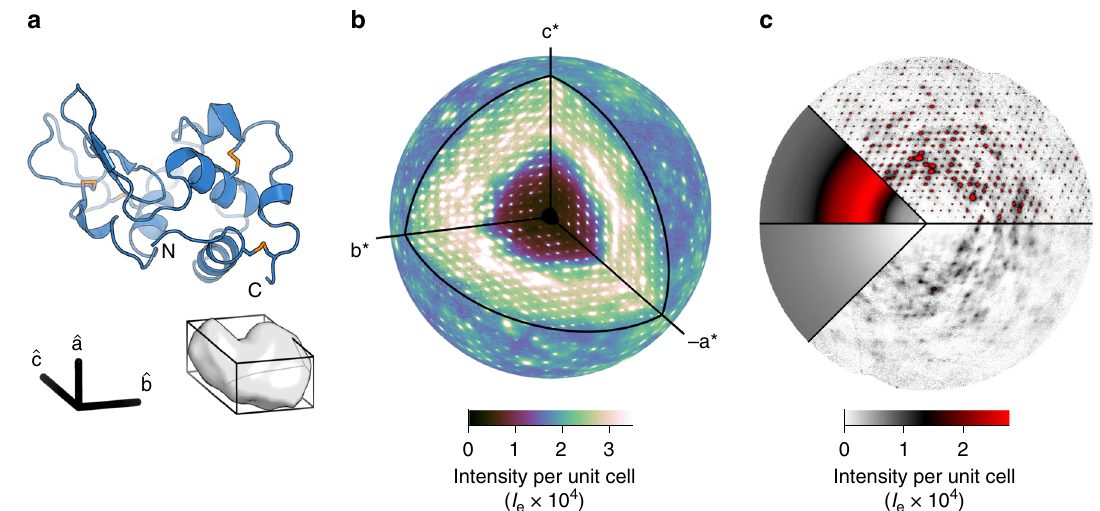
Fig. 1 Diffuse scattering map of triclinic lysozyme with intensities on an absolute scale of electron units ( I e ). a Ribbon diagram of lysozyme (top) and the triclinic unit cell containing one protein (bottom). b A highly detailed three-dimensional map of diffuse scattering was obtained. The outer sphere is drawn at 2 Å resolution. c The total scattering is made up of three components: inelastic Compton scattering (lower left), a broad isotropic ring that dominates the diffuse signal (upper left), and variational features in the diffuse scattering (right). Intense halos are visible in the layers containing Bragg peaks ( l = 0 plane, upper right). Cloudy scattering is best visualized in the planes mid-way between the Bragg peaks ( l = 1 ∕ 2 plane, lower